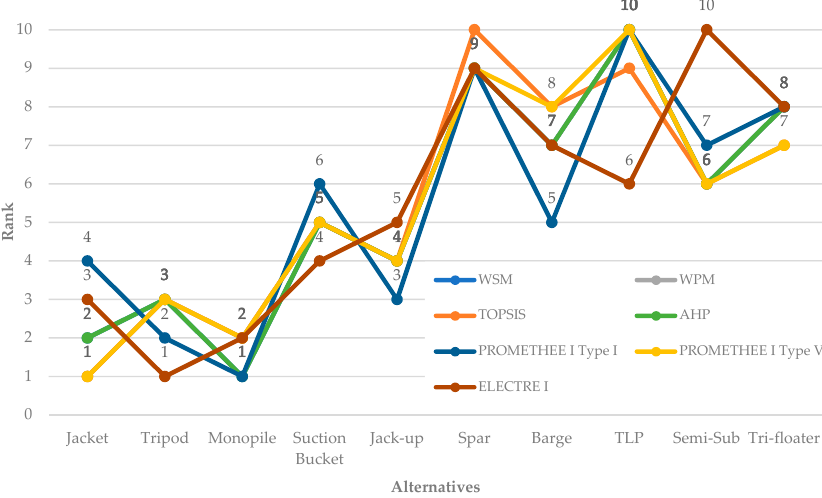
Figure 5. Ranks comparison for the WSM, WPM, TOPSIS, AHP, PROMETHEE I and ELECTRE I methods.